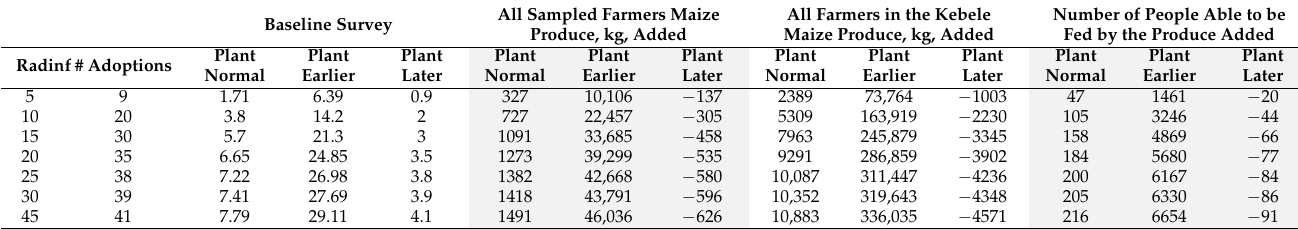
Table A7. Adoption rate of influence of radio, crop productivities of adopted numbers, and number of people able to be fed under more rain conditions.